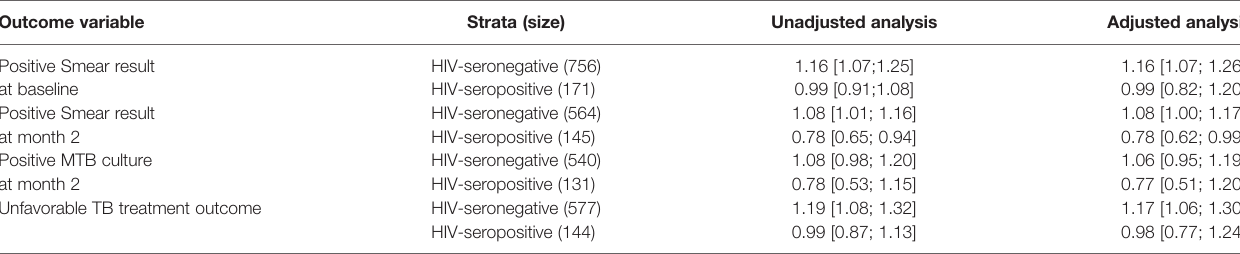
Both analysis control for HIV serology and its interaction with baseline neutrophil. † Model adjusting for the propensity score, which was regressed on the following covariates: sex, age, race, smoking status, alcohol consumption, education level, income status, cavitation on chest radiograph, study site, HIV status, DOT (for unfavorable TB treatment outcome) and (log- transformed) platelets, lymphocytes, glycated hemoglobin and hemoglobin values; results expressed in odds ratios (OR) with 95% con fi dence